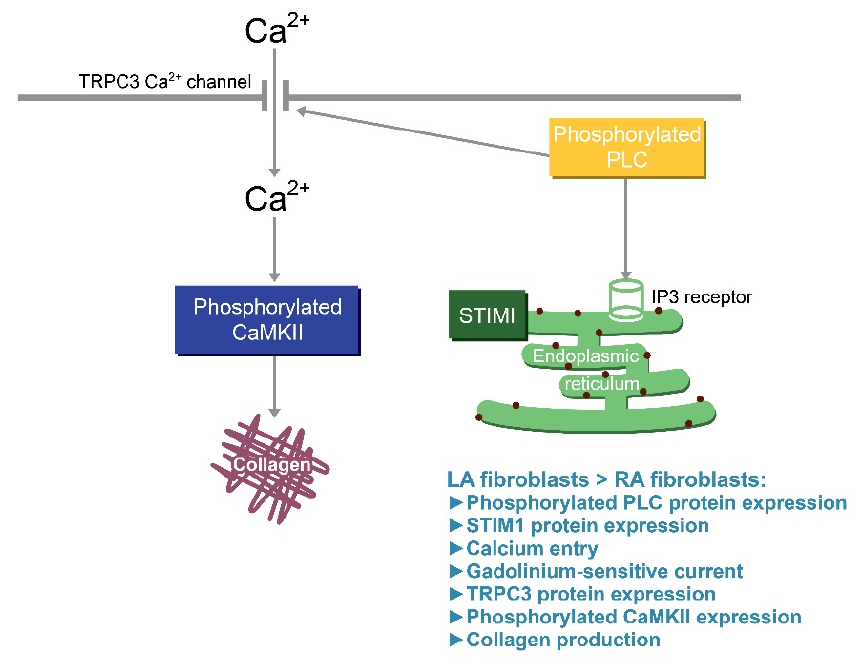
Figure 6. Illustration of the proposed mechanism that contributes to the differential collagen pro- duction in left atrium (LA) and right atrium (RA) fibroblasts. The diversities of the phosphorylated phospholipase C (pPLC) signaling and the expression of transient receptor potential canonical (TRPC) 3 Ca 2+ channels activate different levels of Ca 2+ influx, which may induce a different phosphorylated Ca 2+ /calmodulin-dependent protein kinase II (CaMKII) expression and collagen production between LA and RA fibroblasts. The different levels of stromal interaction molecule 1(STIM1) in LA and RA fibroblasts may also contribute to the diversity of collagen production via the activation of the Orai channel. IP3: Inositol trisphosphate.